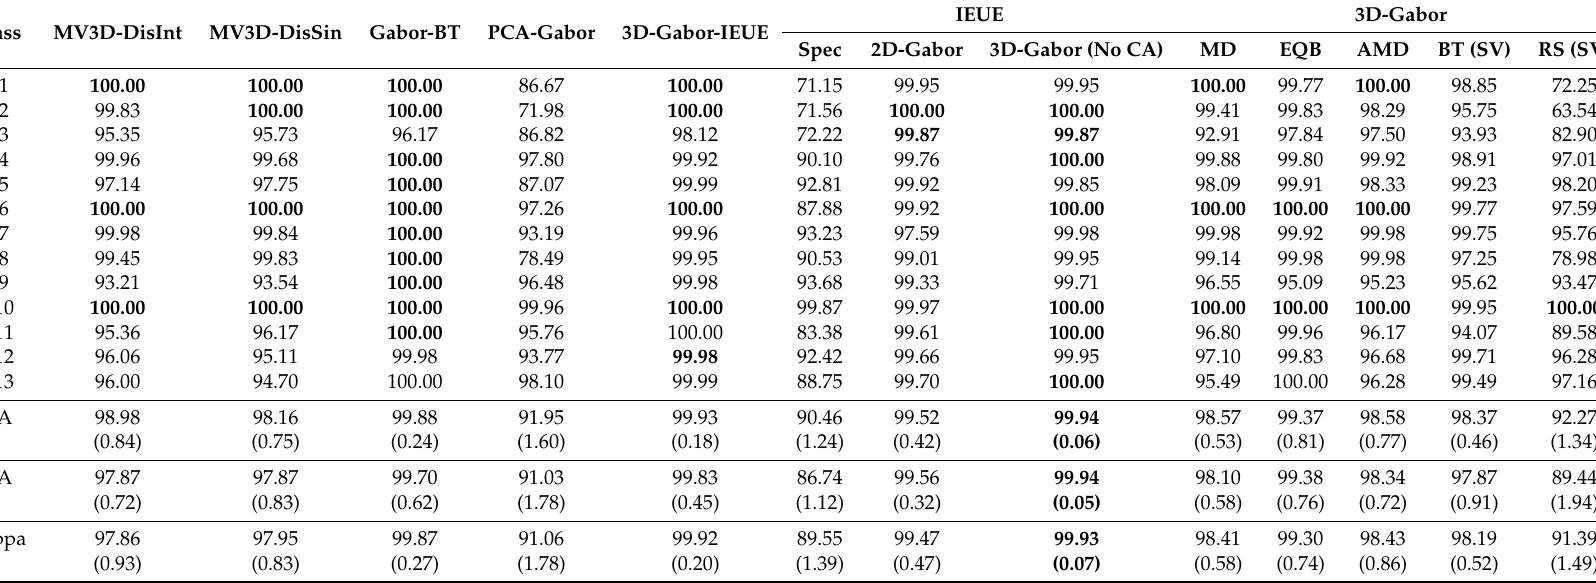
Table 4. Classification accuracies [ % ] of different view generation and sampling selection methods for the KSC dataset, using 65 initial training samples (5 per class) and 75 selected samples. For PCA-Gabor, 143 samples (11 per class) are used for training. The numbers in parenthesis are standard deviations. Bold values indicate the best result for a